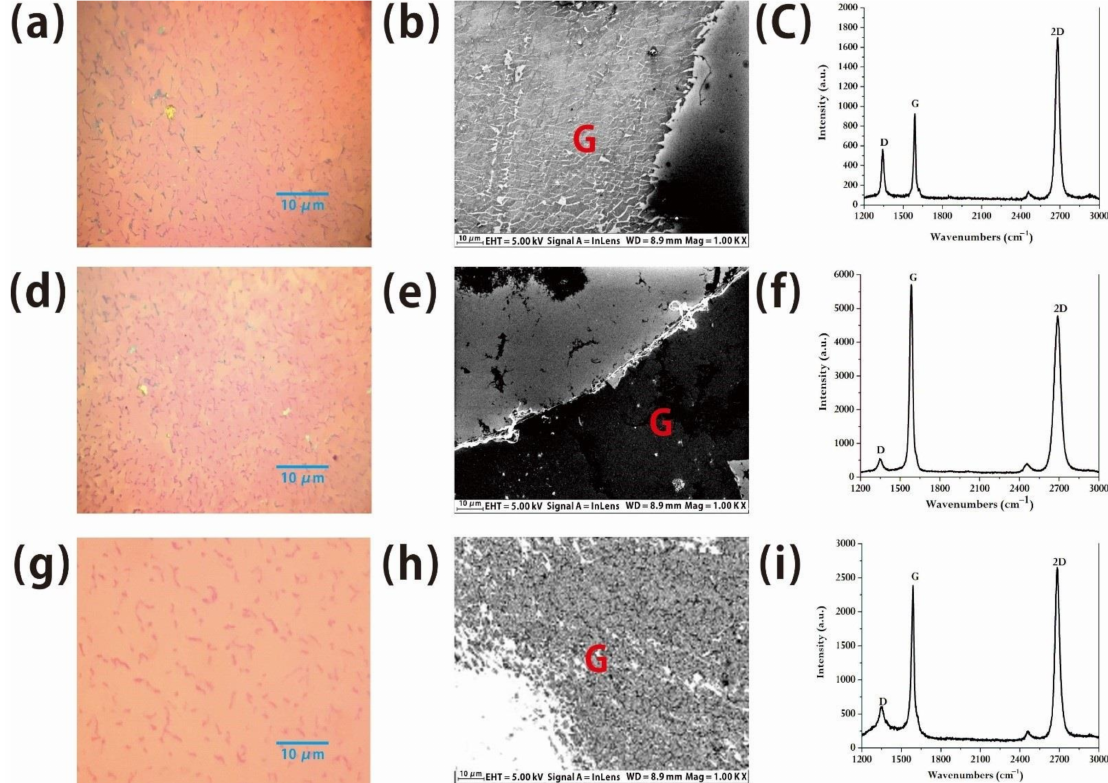
Figure 3. ( a , d ) are optical microscopic images of graphene at obtained 1060 ◦ C by liquid benzene (at this time, the pressure of benzene exclusion is 55.6 Pa), and the partial pressures of benzene are 17.3 Pa, 4.4 Pa, respectively. ( b , c , e , f ) are the corresponding electron micrographs and Raman spectra of graphene. ( g ) is the optical microscopic image of graphene obtained at 500 ◦ C by liquid benzene while the partial pressure of benzene is 1.1 Pa, with ( h , i ) to be the correspondent electron micrographs and Raman spectra of